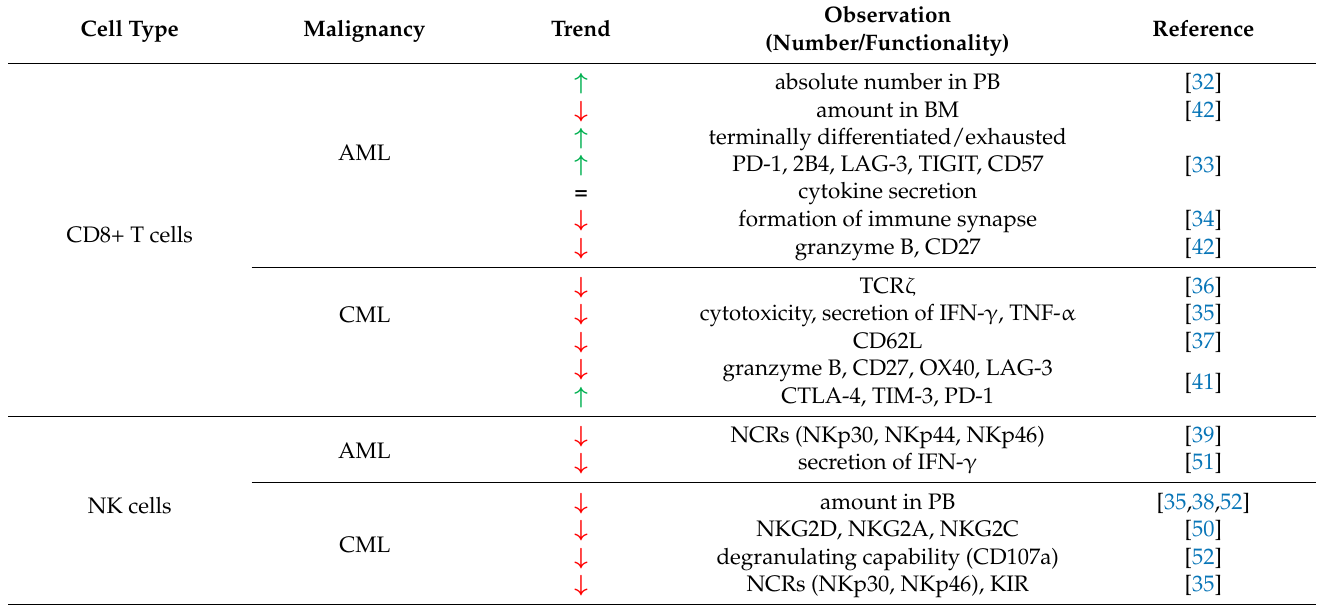
Table 1. Changes observed in phenotype and activity of immune effector cells, CD8+ T cells and NK (natural killer) cells, in acute and chronic myeloid leukemia. While the general observation of decreased effector function is relevant to both CML and AML, different effector mechanisms may be affected in each type of leukemia. Increase of a parameter or expression of indicated proteins is marked with a green, upward arrow, whereas decrease is marked with a red, downward arrow. No observed changes are marked with an equal